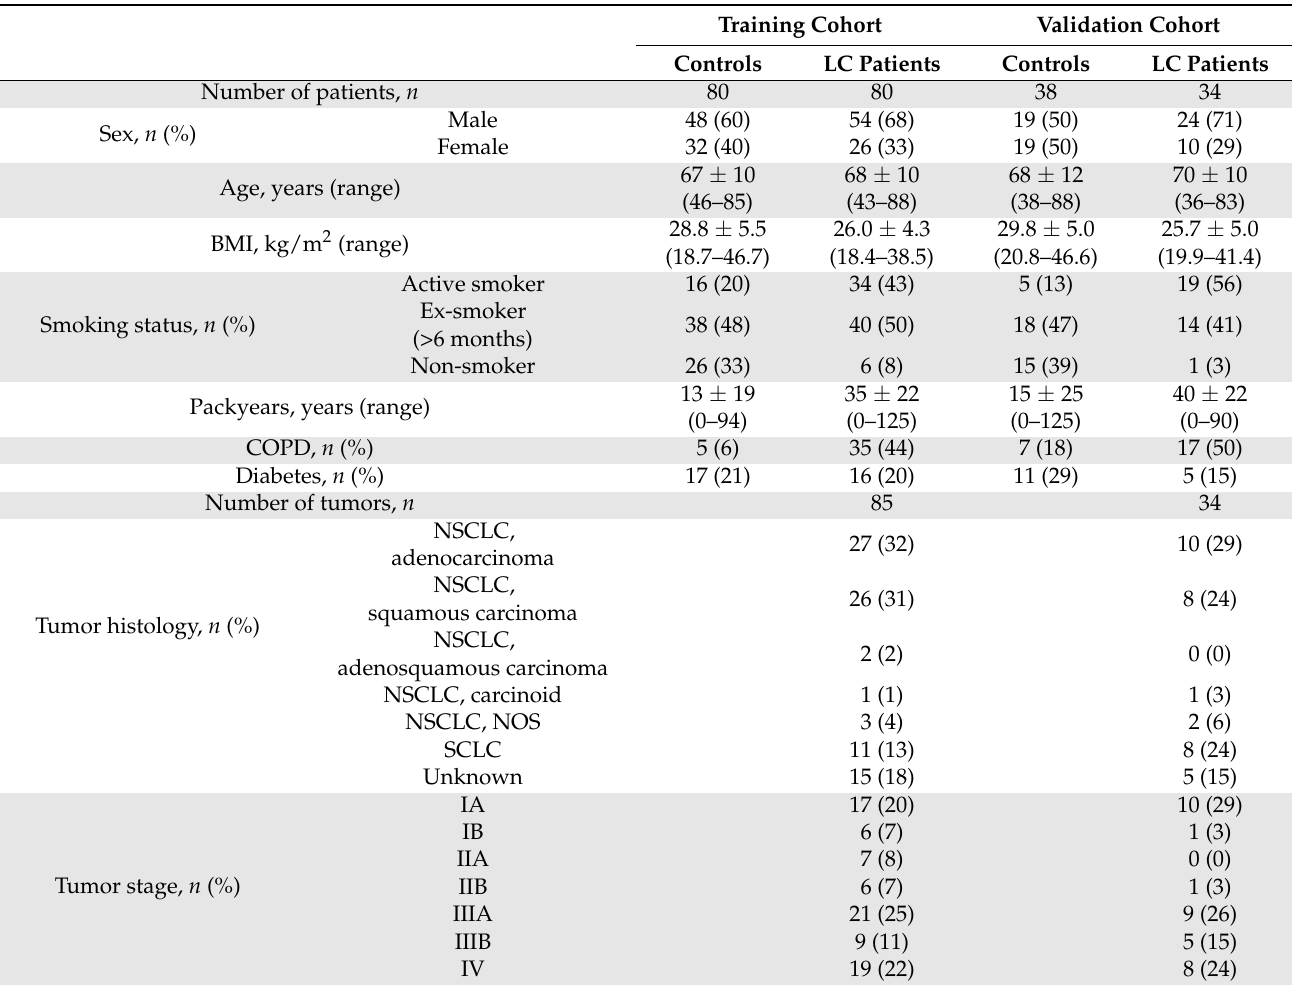
Table 2. Clinical characteristics of the subjects included in the training and validation cohort. BMI: body mass index; COPD: chronic obstructive pulmonary disease; LC: lung cancer; NOS: not otherwise specified; NSCLC: non-small-cell lung cancer; SCLC: small-cell lung cancer. Note: clinical tumor staging in the NCT02024113 study was performed according to TNM classification, 7th